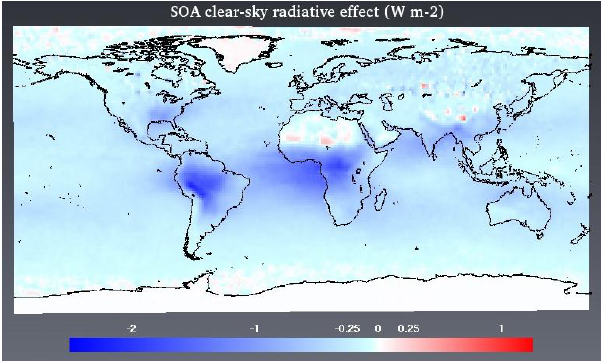
Figure 10. Difference in clear-sky top of atmosphere SW flux (SOA – no SOA)